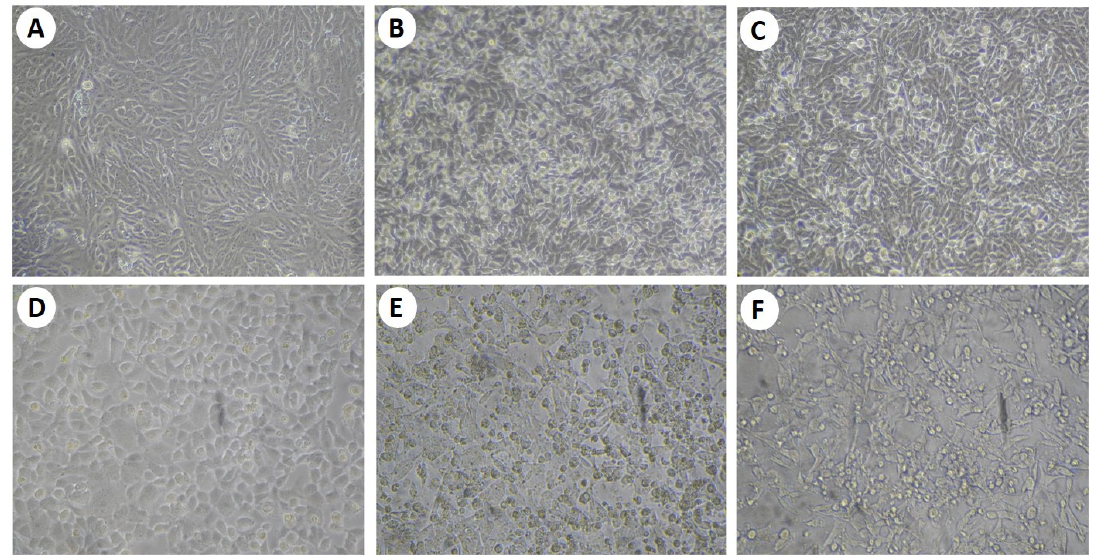
Figure 9. Effect of AgNO 3 and Asf-AgNPs on cell morphology of MCF7 and Vero cell line at 48 h. ( A ) Control (Vero), ( B ) AgNO 3 treated on Vero (40 μ g/mL), ( C ) Asf-AgNPs treated on Vero (40 μ g/mL), ( D ) Control (MCF7), ( E ) AgNO 3 treated on MCF7 (40 μ g/mL), ( F ) Asf-AgNPs treated on MCF7 (IC 50 – 40 μ g/mL).